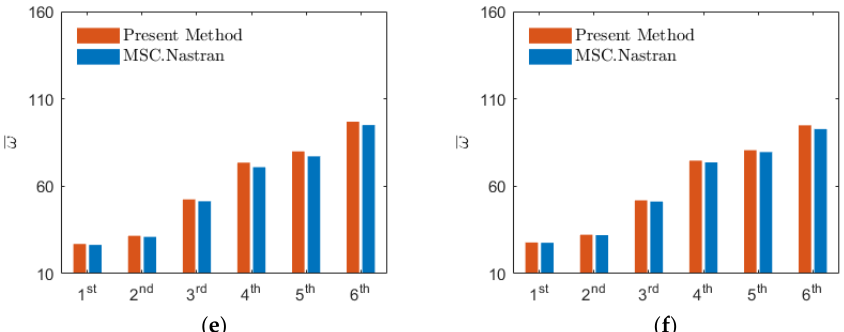
Figure 5. First six dimensionless natural frequencies of the HCS plate with no temperature change under different boundary conditions: ( a ) SSSS; ( b ) CCCC; ( c ) CSCS; ( d ) SCSC; ( e ) CFCF; ( f ) FCFC.